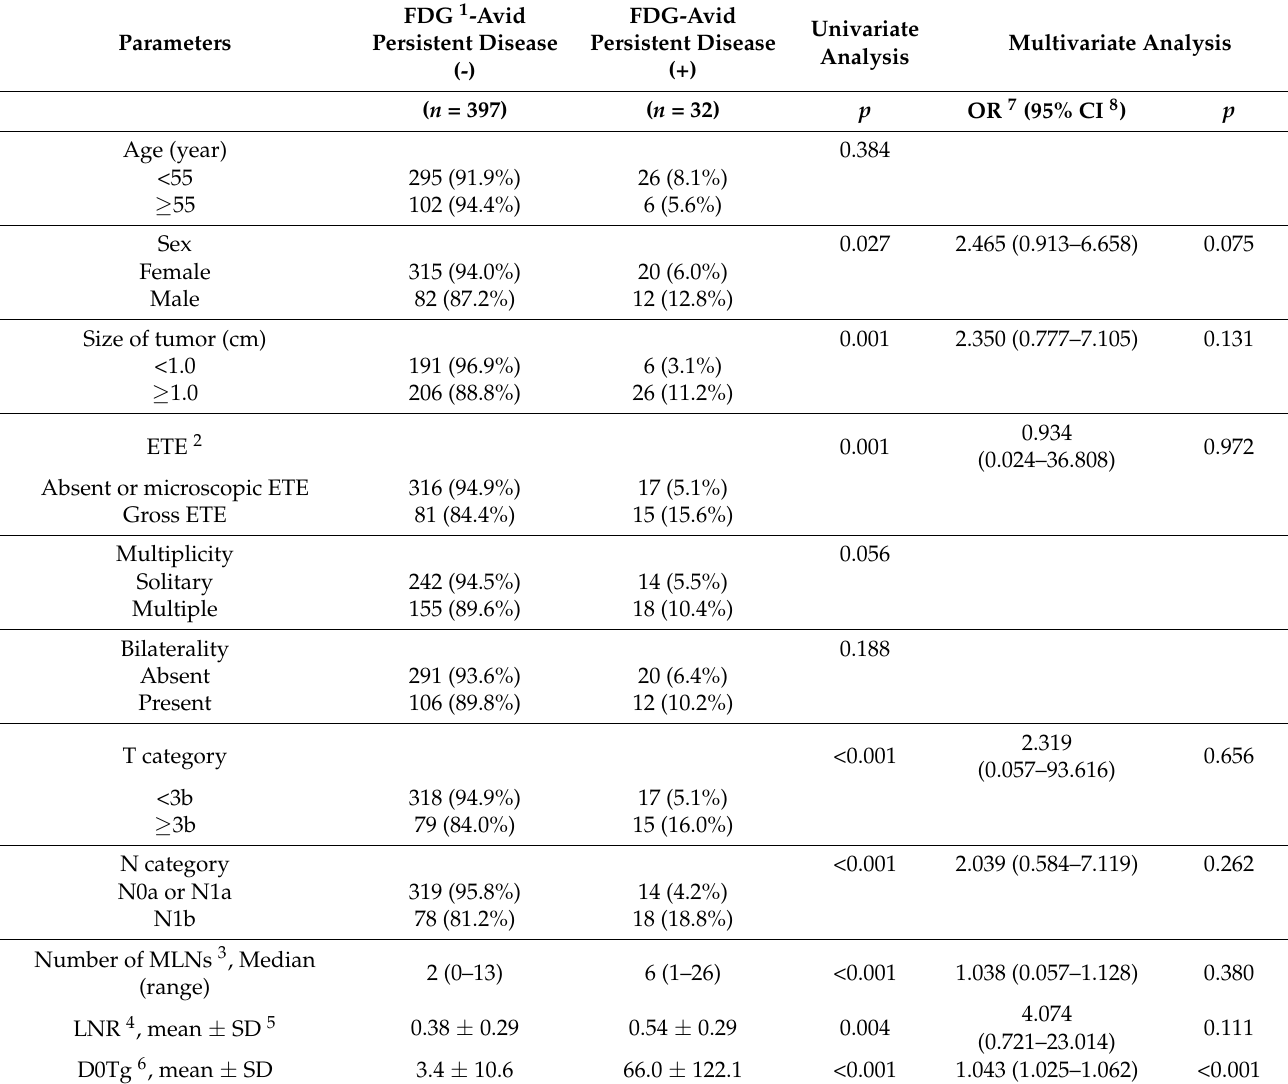
Table 2. Clinicopathological factors associated with the detection of FDG-avid persistent disease on PET/CT. FDG 1 Parameters